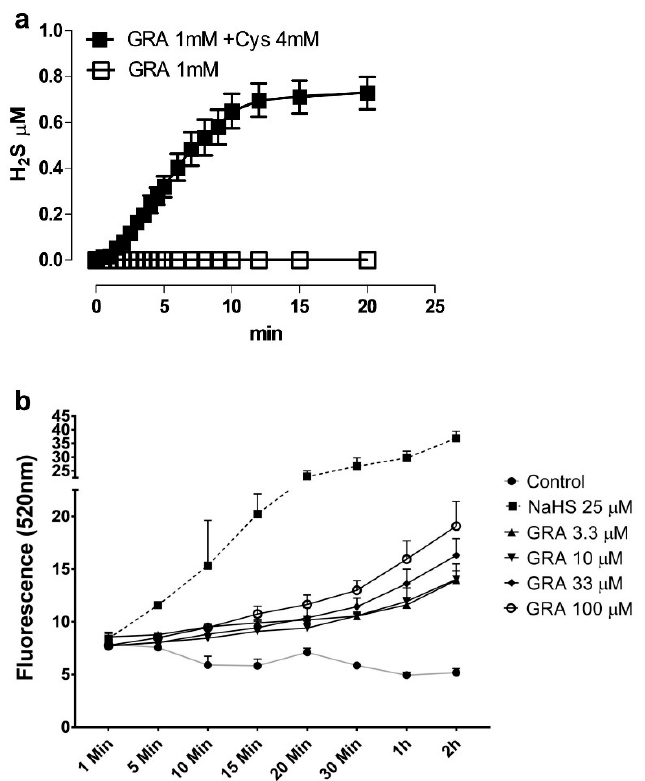
Figure 1. Detection of H 2 S levels in GRA dissolved in aqueous buffer and time course detection of H 2 S levels in hMSCs after stimulation with GRA. ( a ) Graphs of H 2 S concentration in the buffer as detected by amperometric measurements ( N = 3 independent experiments). ( b ) Graphs of time-course measurement of intracellular H 2 S in hMSCs stimulated with 3.3–100 µ M concentrations of GRA at the indicated time points as detected by fluorimetric analysis. Cells treated with 25 µ M NaHS were used as a positive control; cells untreated were used as negative controls ( N = 3 independent experiments).